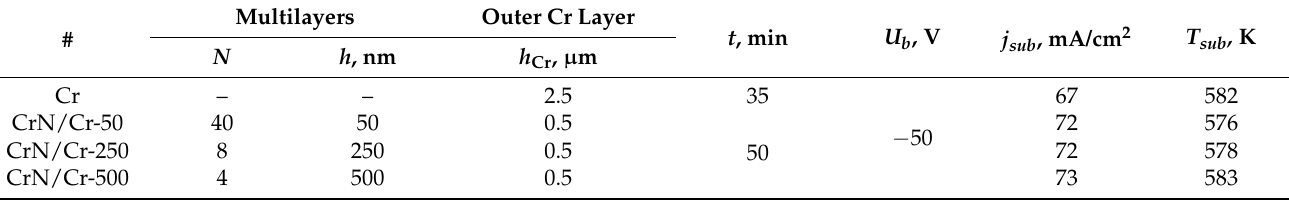
Table 1. Deposition parameters of the